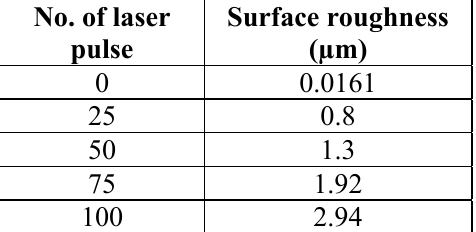
Table 5: Relation between Surface roughness and number of laser pulses No. of laser Surface roughness pulse